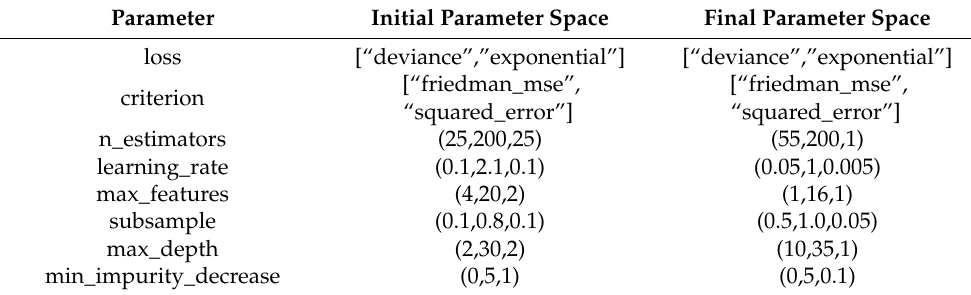
Table 3. GBDT parameter space for training